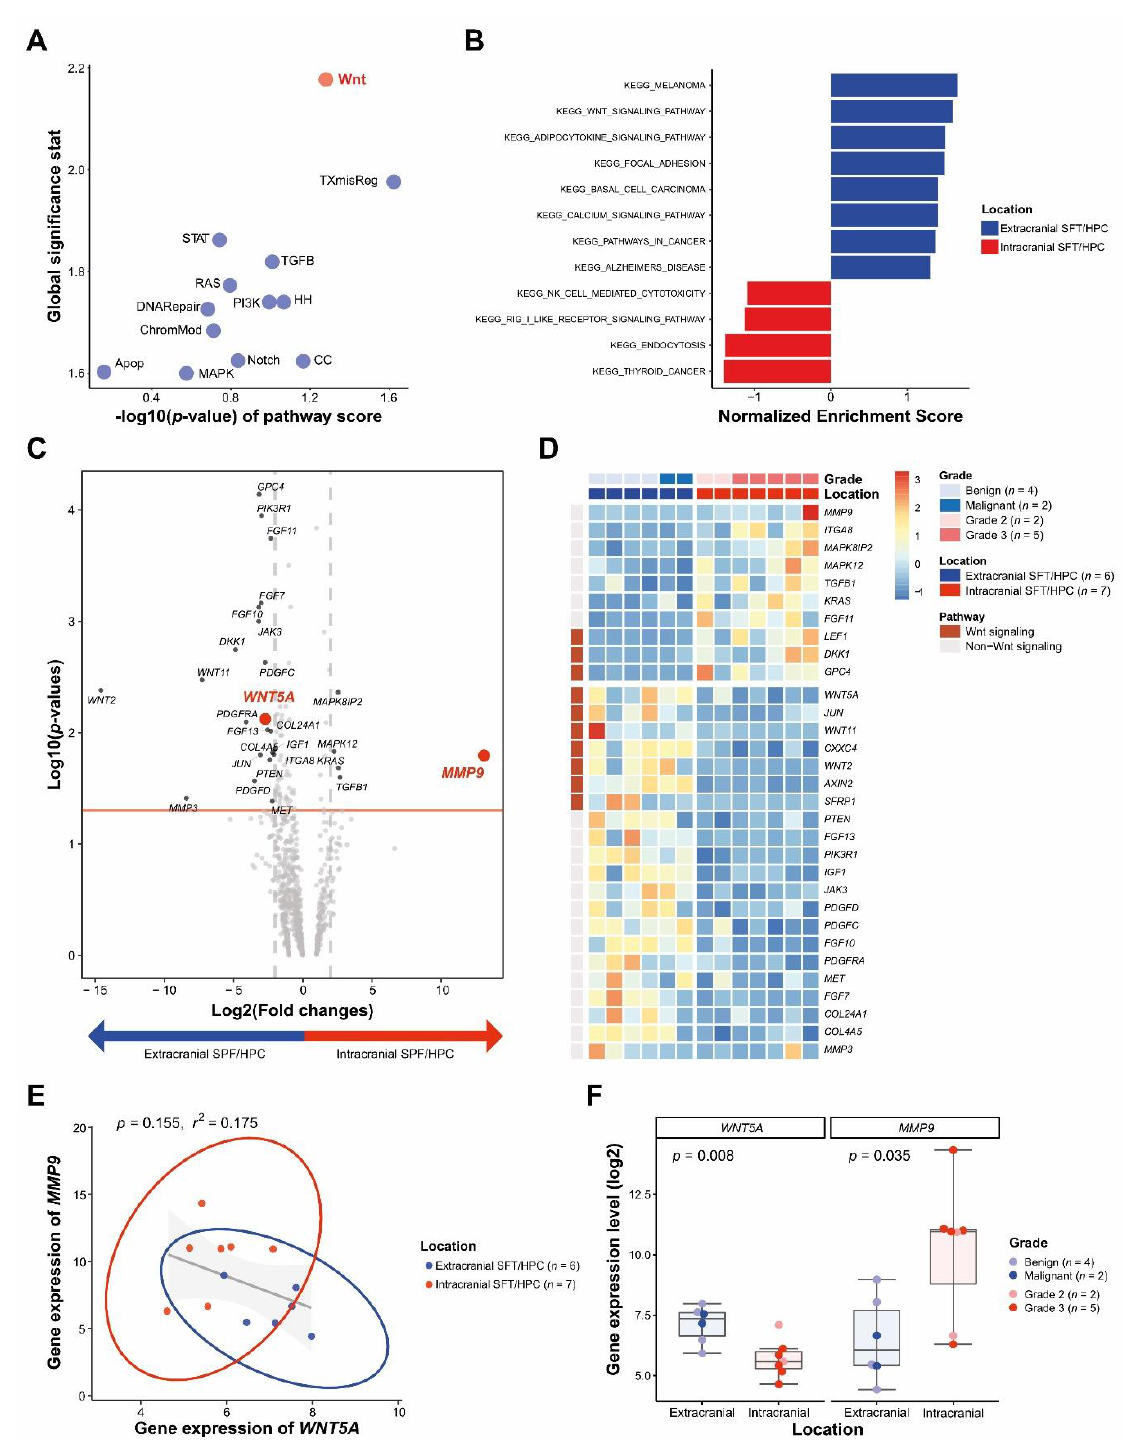
Figure 1. Differentially expressed genes in ic SFT/HPC and ex SFT/HPC. ( A ) Based on global significance statistics and pathway dysregulation p -values, the greatest difference between the two groups was observed in the WNT signaling pathway. ( B ) Gene set enrichment analysis (GSEA) showed that WNT signaling and focal adhesion pathways of KEGG gene sets were enriched in ex SFT/HPC compared to ic SFT/HPC. ( C ) Volcano plot of differentially expressed genes according to location, a fold change in expression > 2, and p < 0.05. ( D ) Heatmap of representative genes showing differential expression profiles in ic SFT/HPC and ex SFT/HPC. ( E ) Linear correlation analysis of WNT5A with MMP9 expression. Circles represent groupings based on the location of SFT/HPC. ( F ) Box plots showing that the expression level of WNT5A was high in ex SFT/HPC and that of MMP9 was high in ic SFT/HPC. 3.3. Differential WNT5A and MMP9 Protein Levels in icSFT/HPC and exSFT/HPC